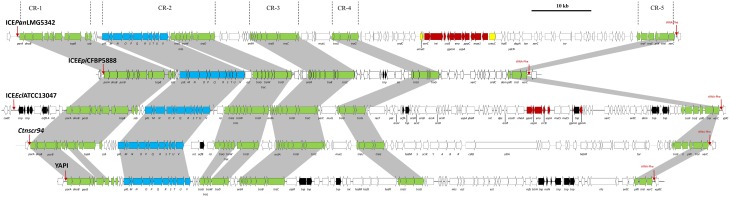
Schematic diagram of ICEPanLMG5342 and closely related ICEs showing the extensive synteny that exists between the CRs. ICEEpiCFBP5888 and ICEEclATCC13047 were identified from the genome sequences of E. piriflorinigrans CFBP 5888T and E. cloacae subsp. cloacae ATCC13047T, respectively. The Genbank files for CTnscr94 of S. enterica subsp. enterica serovar Senftenberg 5494-57 and YAPI of Y. pseudotuberculosis 32777 were obtained from the ICEberg database (Bi et al., 2012). Dark gray shaded regions and green arrows indicate the conserved CRs between the ICEs. Black arrows represent transposases.